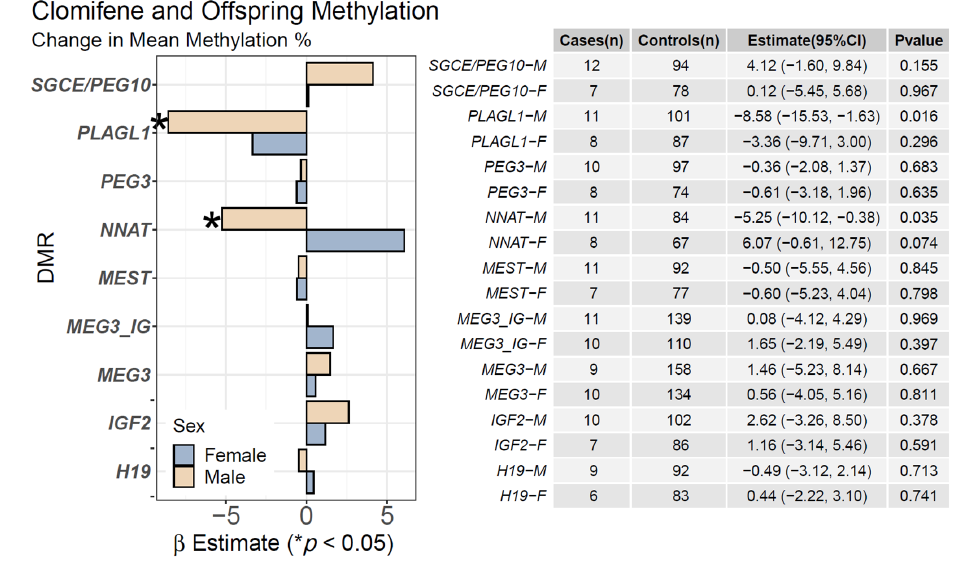
Figure 3. Associations of Clomifene and Mean CpG Methylation: We assessed the relationship between the use of clomifene only and mean CpG methylation at nine DMRs using linear regression. We stratified models by sex and adjusted for pyrosequencing batch, maternal pre-pregnancy BMI, race, maternal age, diabetes, and parity. Estimates ( β ) are shown for males (tan) and females (blue) and represent the mean percentage of methylation change associated with maternal use of clomifene without ART (* p <